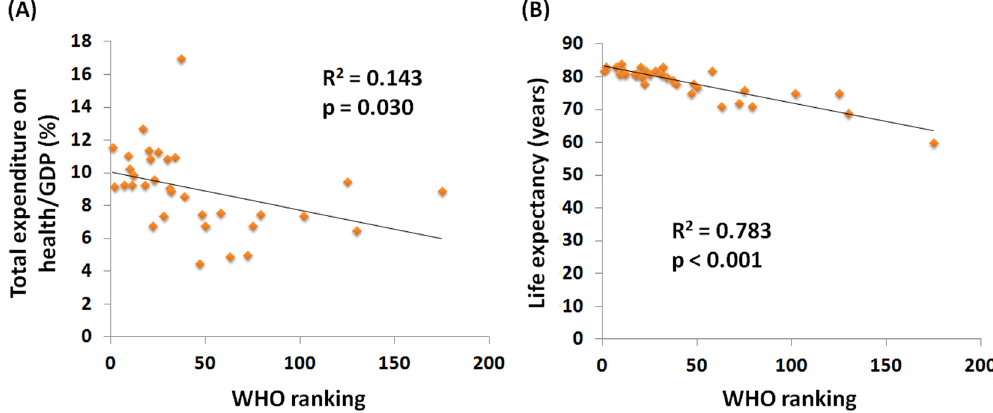
Figure 2. The association between world health organization ranking and ( A ) total expenditure on health/GDP and ( B ) life expectancy among 33 countries.